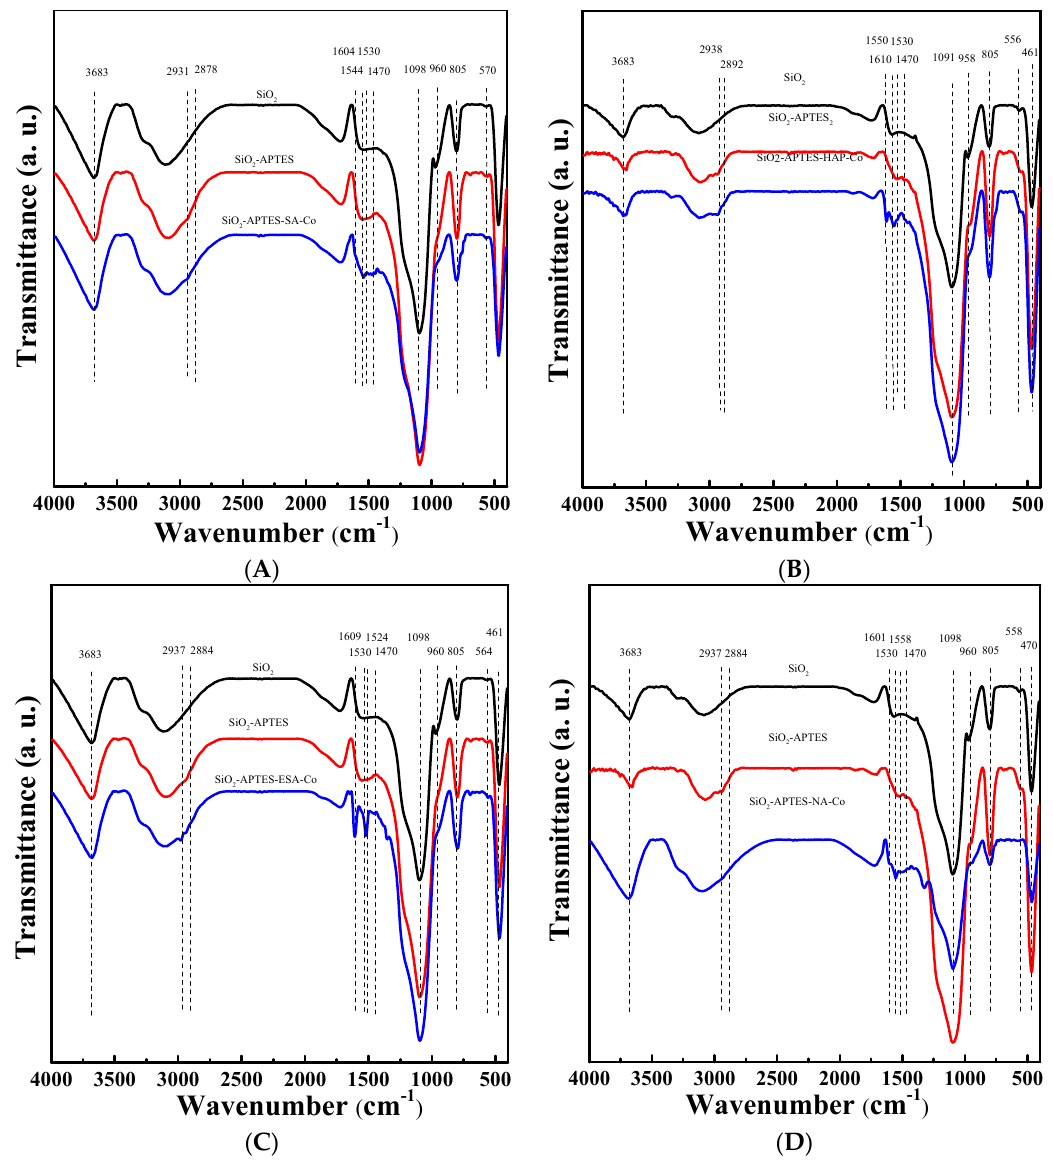
Figure 2. FT ‐ IR spectra of the covalently anchored catalysts SiO 2 ‐ APTES ‐ SA ‐ Co ( A ), SiO 2 ‐ APTES ‐ HAP ‐ Co ( B ), SiO 2 ‐ APTES ‐ EASA ‐ Co ( C ) and SiO 2 ‐ APTES ‐ NSA ‐ Co ( D ) in comparison with the sup ‐ HAP-Co ( B ), SiO 2 -APTES-EASA-Co ( C ) and SiO 2 -APTES-NSA-Co ( D ) in comparison with the port SiO 2 and the intermediate SiO 2 ‐ APTES. support SiO 2 and the intermediate SiO 2